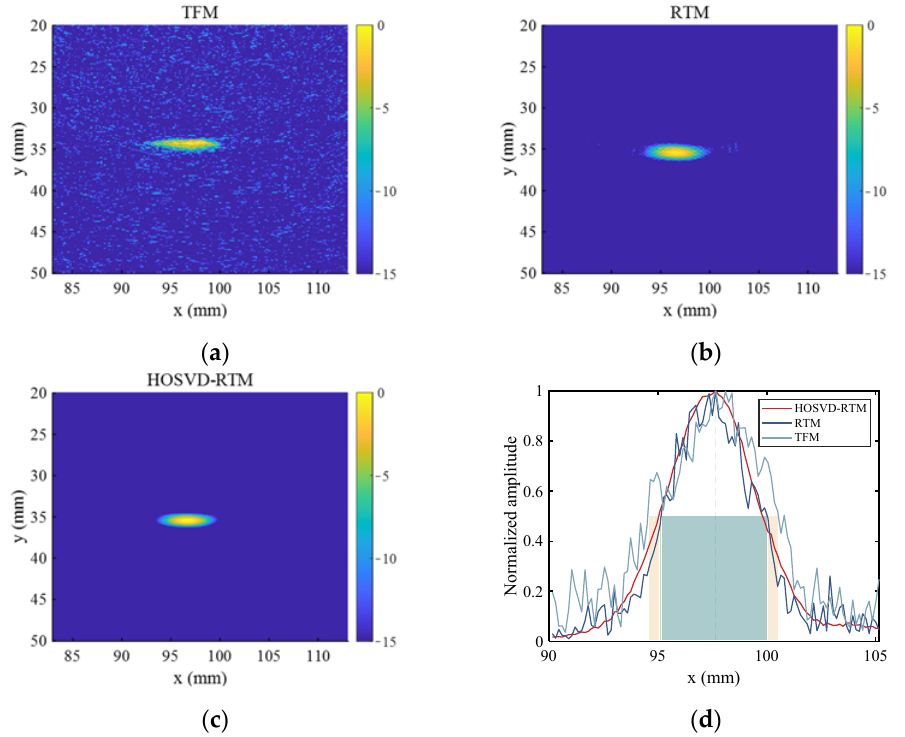
Figure 13. Imaging results obtained with the array composed of 16 elements and different algorithms (( a ) TFM, ( b ) RTM, ( c ) HOSVD-RTM); ( d ) cross-sectional view of defect location.